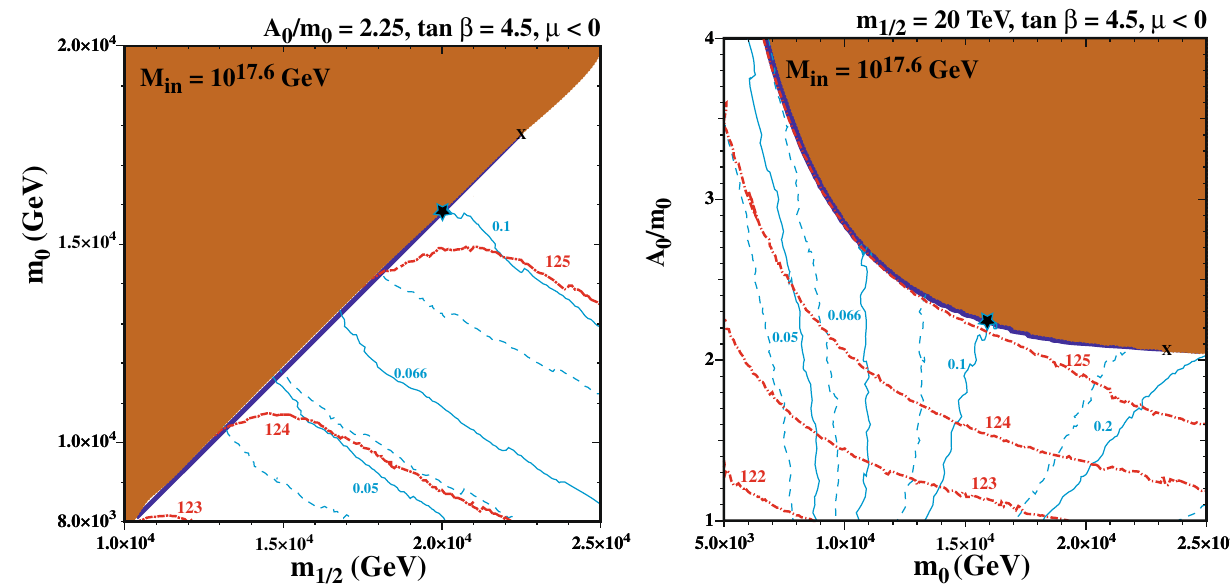
stop, in the narrow dark blue strips the relic LSP density (cid:21) LSP h 2 ∈ ( 0 . 05 , 0 . 2 ) , the dot-dashed red lines are contours of m h calculatedusing FeynHiggs 2.18.0 , and the solid (dashed) blue lines are contours of τ( p → K + ν) in units of 10 35 y calculated with central ( − 1- σ ) values of the decay matrix elements and α s